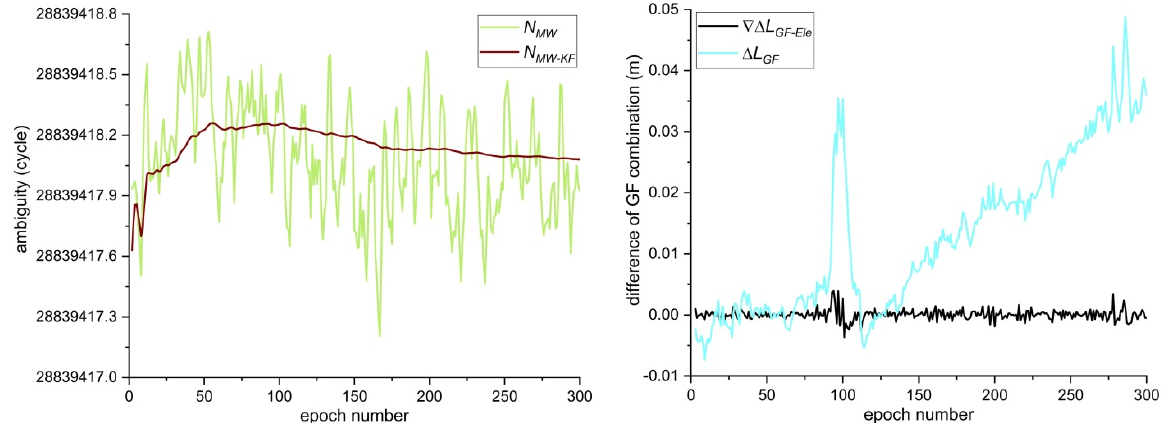
Figure 15. Wide-lane ambiguity and second-order difference GF combination sequence of satellite G26 in ionospheric disturbance environment.